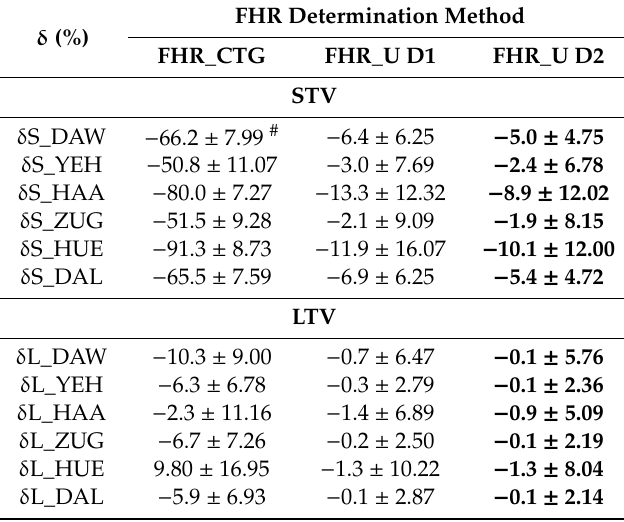
Table 6. Relative errors δ for STV and LTV variability indices, determined for original signals FHR_CTG from a fetal monitor output, and for FHR_U from the new Doppler ultrasound signal analysis methods, in relation to the FHR_E reference signal from